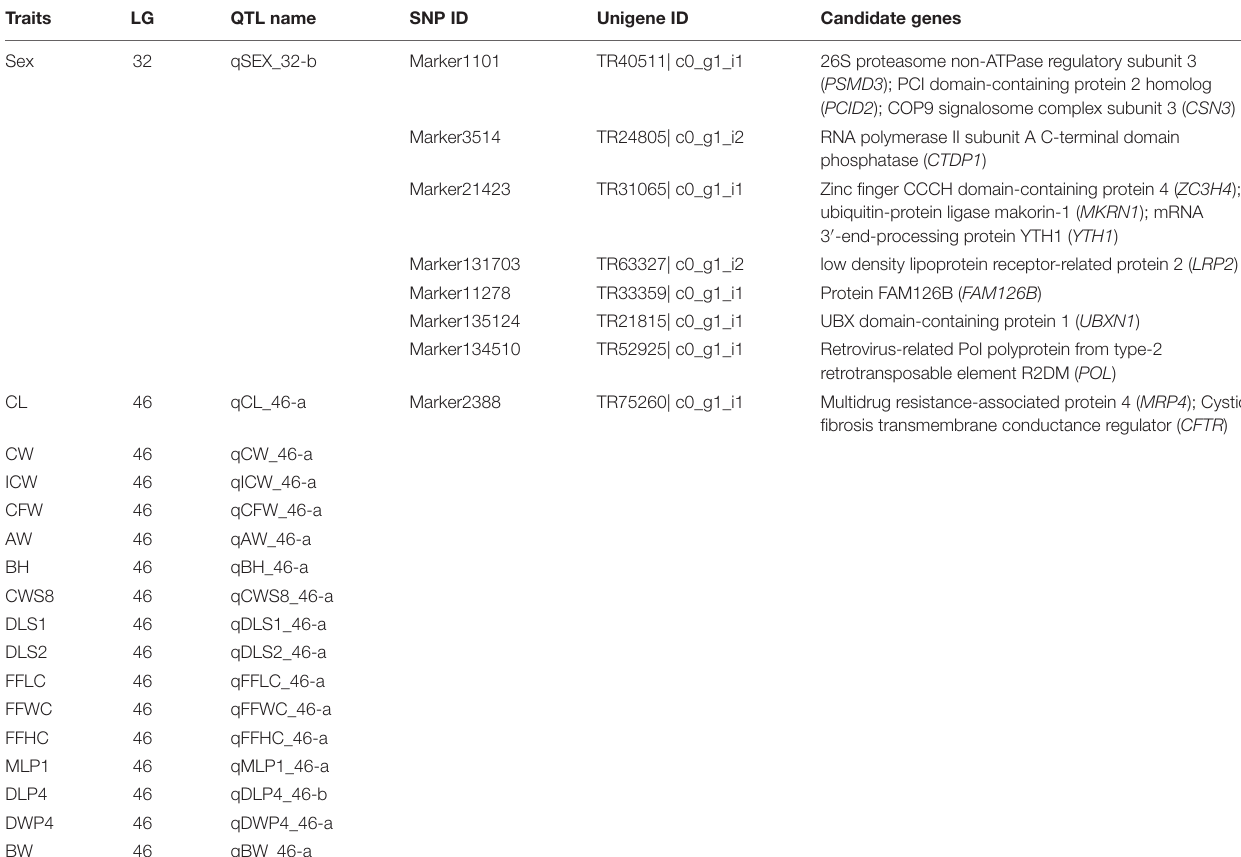
FIGURE 3 | The LOD and PVE values, and the QTL location of CL (qCL_46-a), CW (qCW_46-a), and BW (qBW_46-a) on LG46. TABLE 6 | Summary of candidate genes for sex and growth traits in Scylla paramamosain.